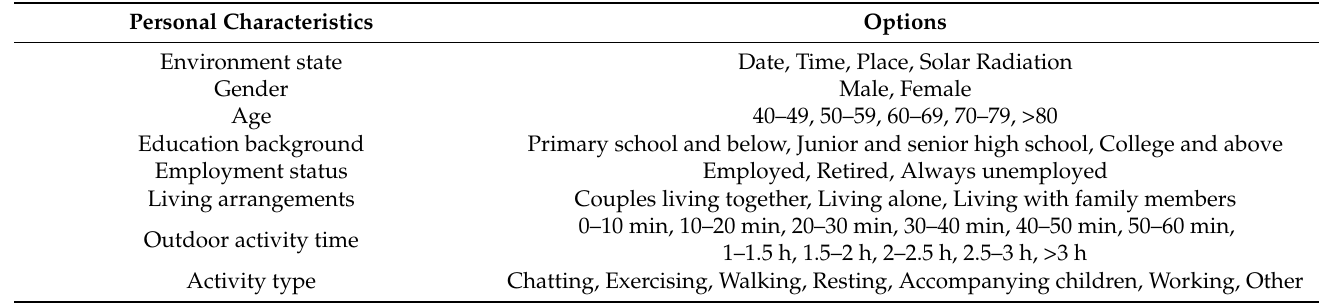
Table 1. Background information of the